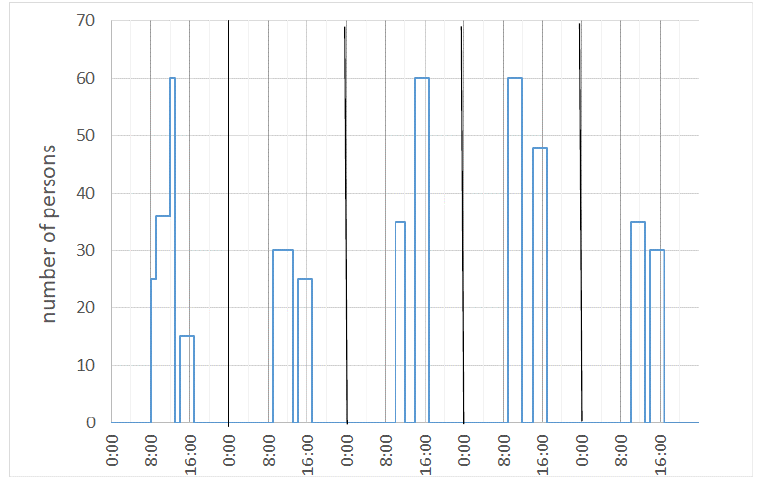
Figure 2. Typical occupancy profile in the lecture rooms during one course week (Monday to Friday).